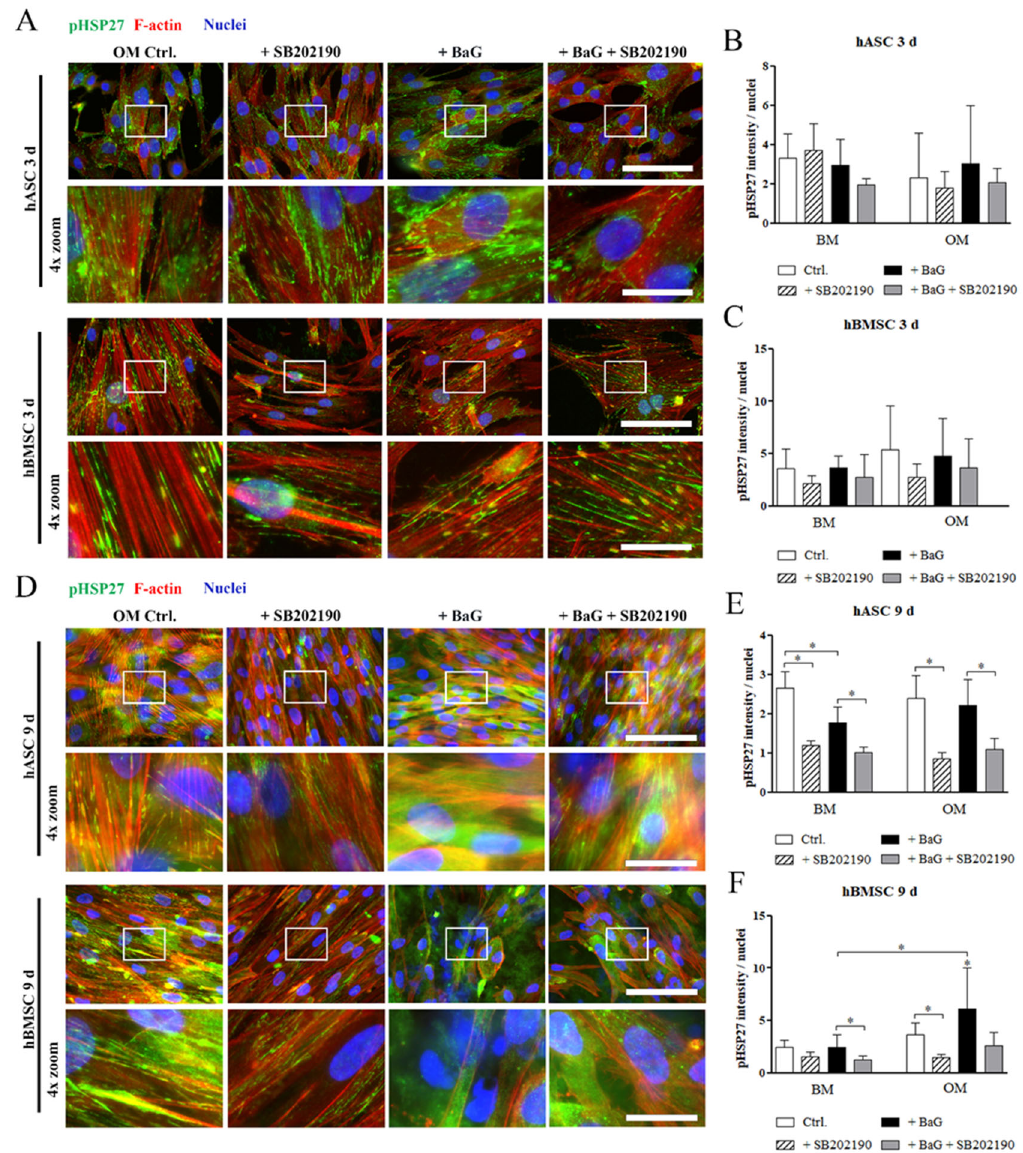
Figure 5. Cellular localization of phosphorylated HSP27 in hASCs and hBMSCs. ( A , D ) Representative images of pHSP28(S78) stained hASCs and hBMSCs, after 3 and 9 days of culture in OM and BaG OM. Fluorescence images were taken with a 40 X magnification and with filters for pHSP27(S78) (Alexa 488, green), actin (Alexa 546, red), and nuclei (DAPI, blue). The 4 X digital zoom images are presented below the corresponding original images, indicated with white rectangles. Secondary antibody controls are presented in Figure S2b. Scale bars are 100 µ m in the original images and 25 µ m in the zoom images. ( B , C , E , F ) Image-based quantification of mean grey values of pHSP27 stained hASCs and hBMSCs normalized with nuclei count. Statistical analysis: hASCs: N = 6–9 (3 d)/8–10 (9 d) images, 2 independent biological replicates of 2 donors; hBMSCs: N = 7–9 (3 d)/7–11 (9 d) images, 2 independent biological replicates of 2 donors. Representative images of hASCs and hBMSCs cultured in BM and BaG BM conditions are in Figure S6b,c. * p < 0.05. The asterisk above the error bar indicates the statistical difference compared to the BM control, and other comparisons are indicated with lines. Abbreviations: basic medium, BM; osteogenic medium, OM; and bioactive glass, BaG.